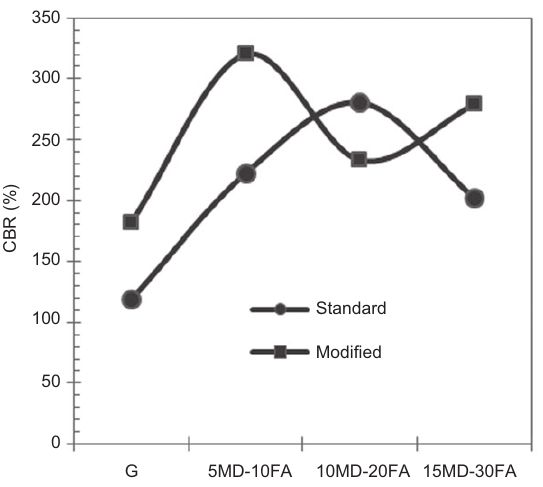
Figure 4 California bearing ratio.